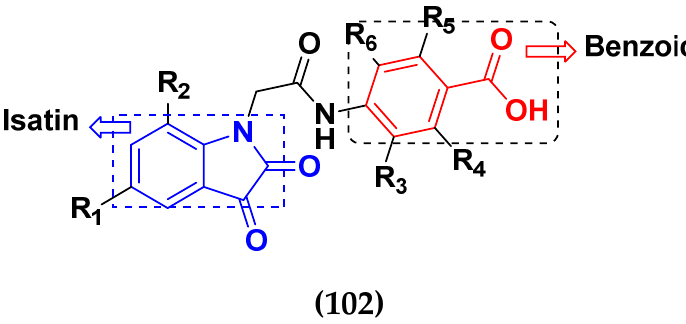
structure of isatin-based benzoic acid hybrids is given in Figure 97 and in vitro cytotoxicity of compounds 102 ( a – d ) against human cancer cell lines is shown in Table 87 [176].